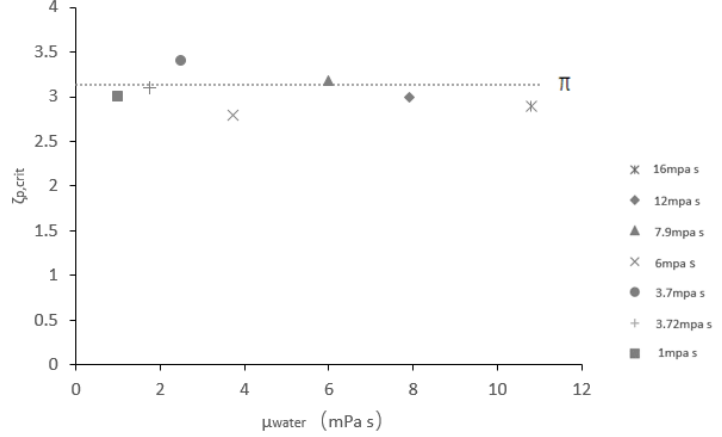
Figure 11. The relationship between 𝜁 (cid:3043),(cid:2913)(cid:2928)(cid:2919)(cid:2930) and the viscosity of the aqueous phase.